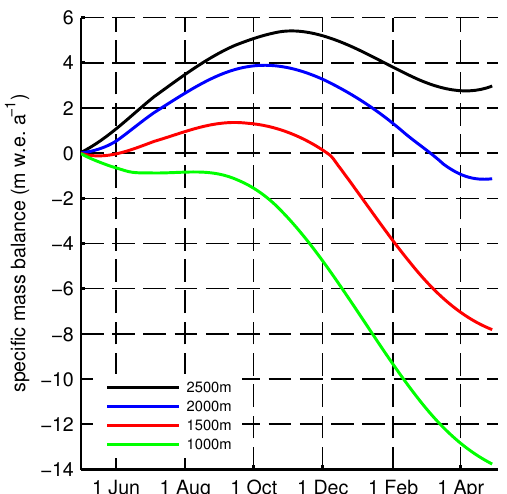
Fig. 6. Temporal evolution of the annual cumulative mass balance, shown in Fig. 5, at selected altitudes. The time evolution is shown during one mass balance year, which starts on 1 May and ends on 30 April.